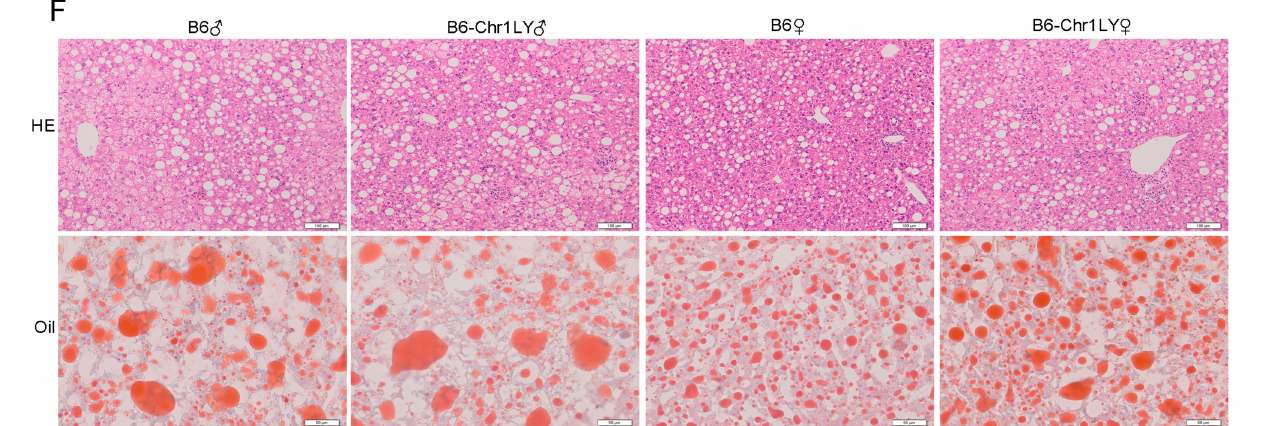
Figure 2. HFD-fed B6-Chr1LY line showed significant abnormalities in body weight, lipid metabolism and liver lesions. ( A ) Average body weight trajectory in HFD-fed male mice ( n = 4–5 per group). ( B ) Average body weight trajectory in HFD-fed female mice ( n = 5 per group). ( C ) The serum lipid levels (CHO, TG, HDL-C, and LDL-C) of 20-week-old C57BL/6J and B6-Chr1LY mice (HFD fed for 12 weeks) ( n = 5 per group). ( D ) The serum lipid levels (CHO, TG, HDL-C, and LDL-C) of 23-week-old C57BL/6J and B6-Chr1LY mice (HFD fed for 15 weeks) ( n = 4–5 per group). ( E ) The representative H&E and Oil Red O staining in liver sections of 30-week-old C57BL/6J and B6-Chr1LY mice (HFD fed for 22 weeks). Scale bars (H&E staining) = 100 µ m. Scale bars (Oil Red O staining) = 50 µ m. ( F ) The representative H&E and Oil Red O staining in liver sections of 50-week-old C57BL/6J and B6-Chr1LY mice (HFD fed for 42 weeks). Scale bars (H&E staining) = 100 µ m. Scale bars (Oil Red O staining) = 50 µ m. ( A – D ) Data are presented as the mean ± SD. T -test: ** p < 0.01, *** p < 0.001, **** p < 0.0001. ns = not significant. HE: hematoxylin-eosin staining. Oil: Oil Red O staining. CHO: total cholesterol. TG: triglycerides. HDL-C: high-density lipoprotein cholesterol. LDL-C: low-density lipoprotein cholesterol. : female. : male. ♀ ♂ 3.3. HFD-fed B6-Chr1ZZ2 Line Showed Significant Abnormalities in Body Weight,